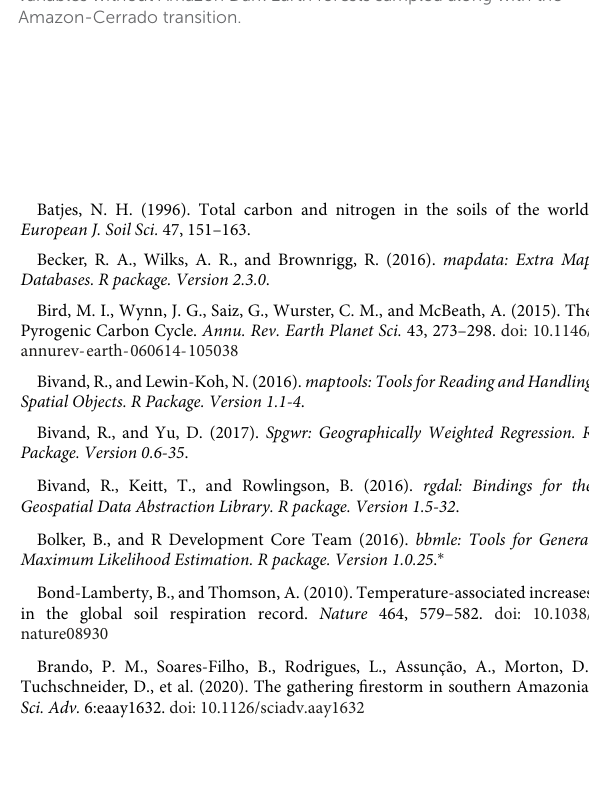
SUPPLEMENTARYFIGURE1 Test of the assumptions of the multiple regression model for the variables with Amazon Dark Earth forests sampled along with the Amazon-Cerrado